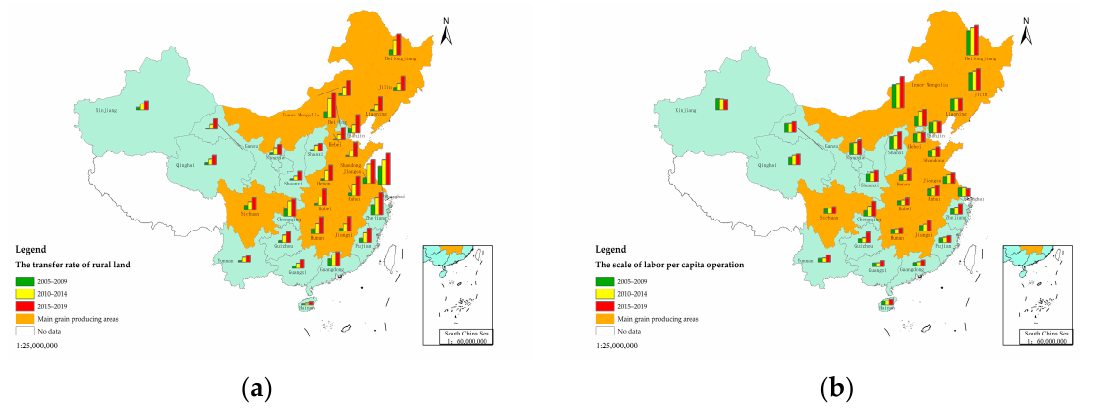
Figure 5. The distribution map: ( a ) the transfer rate of rural land; ( b ) the scale of labor-per-capita operation